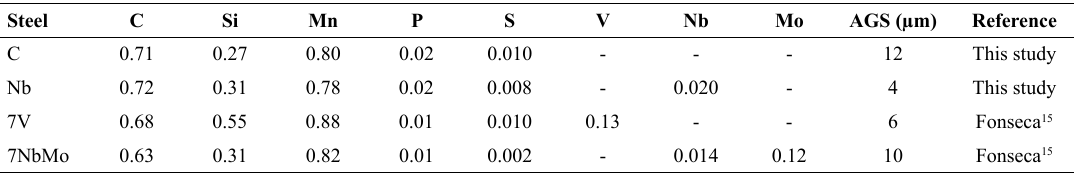
Table 1. Chemical composition (weight %) and austenitic grain size